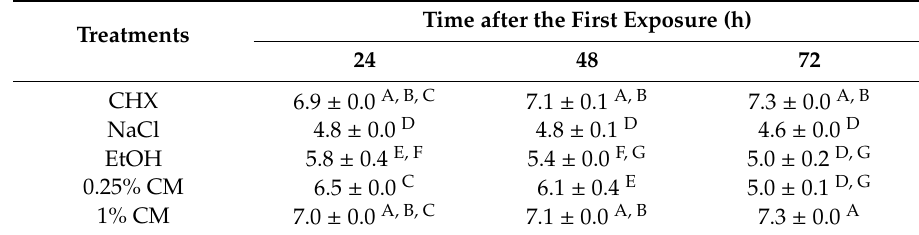
CHX: 0.12% chlorhexidine (positive control); NaCl: saline solution (negative control); EtOH: ethanol:phosphate buffer solution (vehicle control); 0.25% CM: 0.25% chitosan microparticles; 1% CM: 1% chitosan microparticles. Data are expressed as mean ± standard deviation (n = 4). Values not sharing the same letter (A, B, C, D, E, F, G) are significantly different from each other; ANOVA, Tukey–Kramer post-hoc test, p < 0.05.